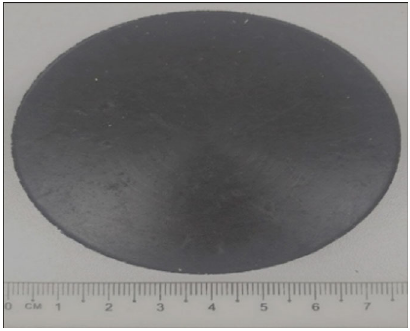
Fig. 1 Disc specimen of an activated carbon-epoxy composite derived from palm